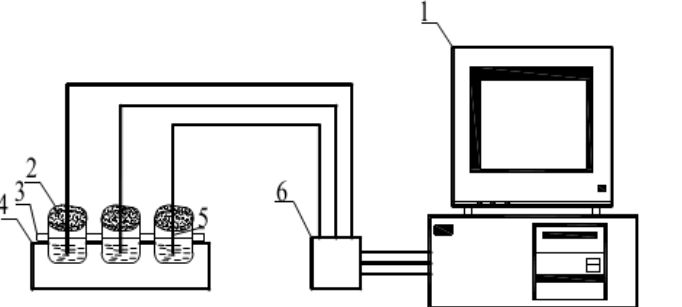
Figure 3. Schematic diagram of step cooling experimental system.